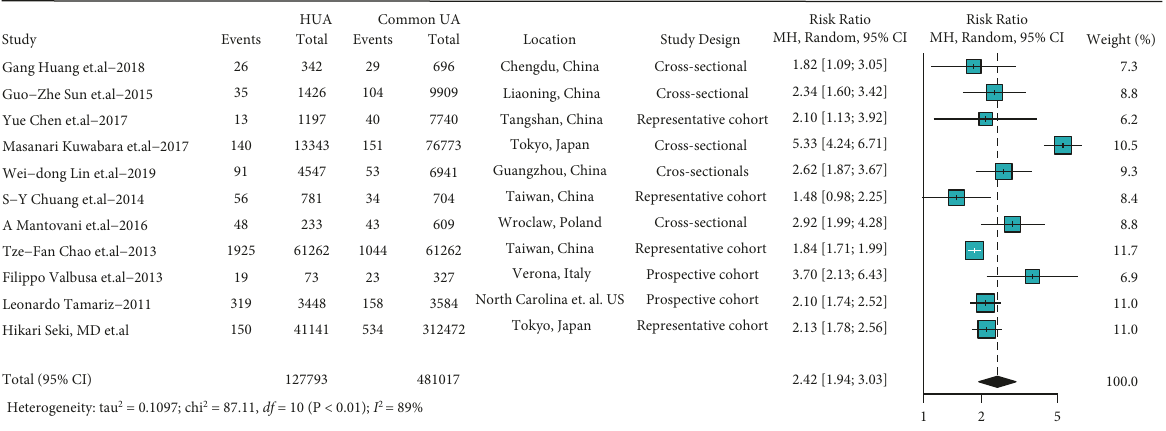
HUA Common UA Risk Ratio Risk Ratio MH, Random, 95% CI MH, Random, 95% CI